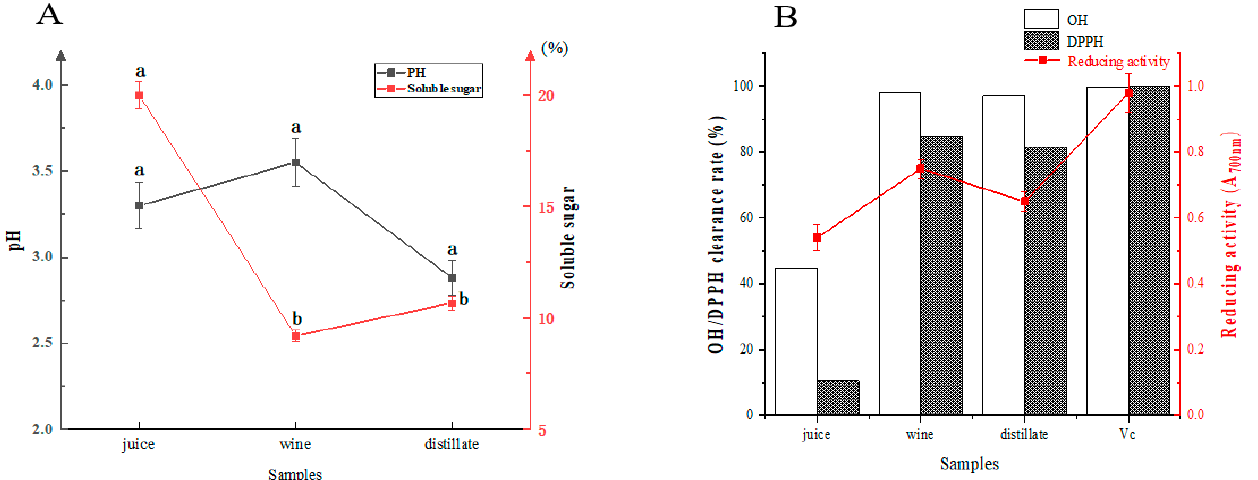
Figure 2. Comparison of the physicochemical indices ( A ) and antioxidant activities ( B ) of SJ, SW and DL ( n = 3). Error bars represent the standard deviation (SD). a and b represent significant difference.